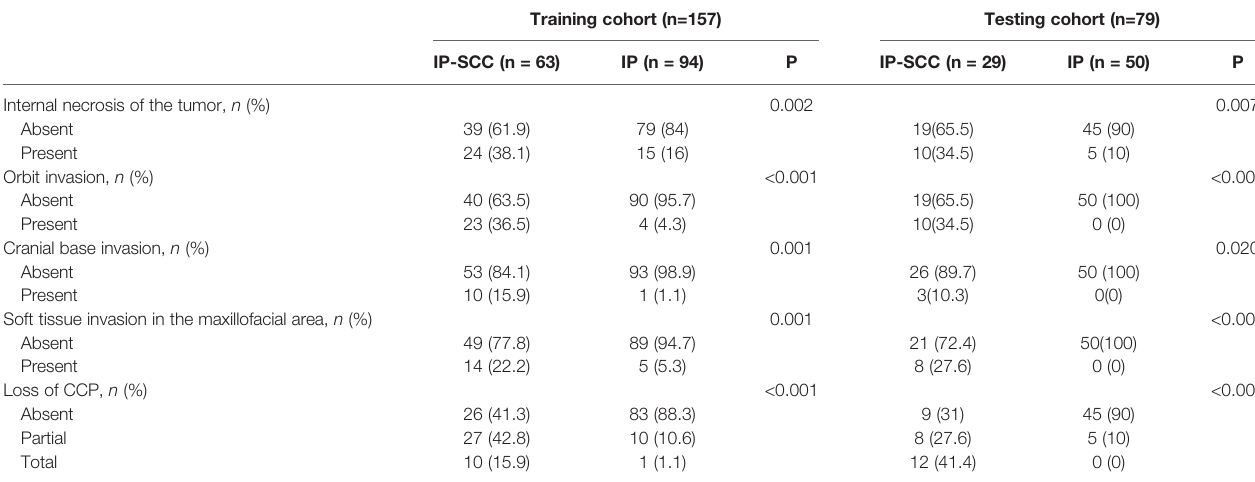
TABLE 2 | Morphological features of patients in training and Testing cohorts.